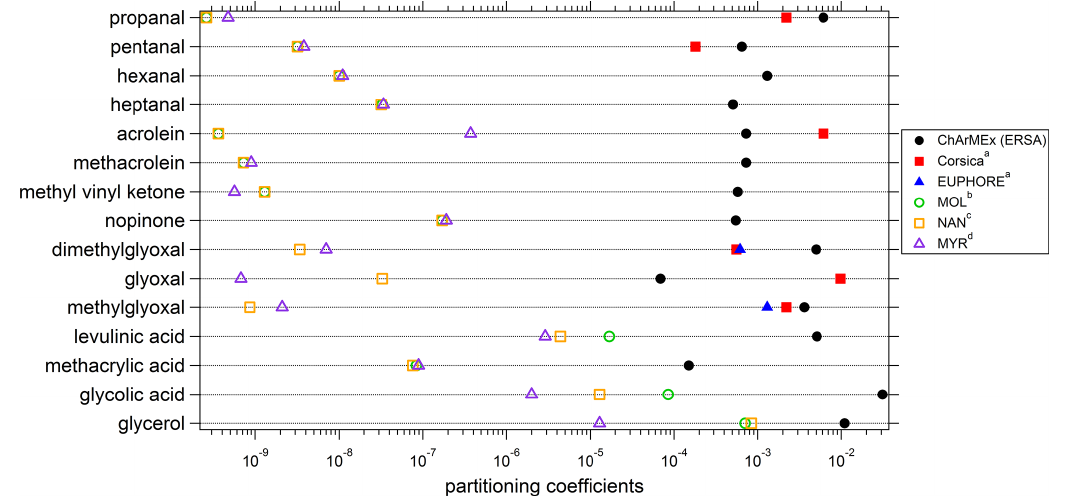
Figure 13. Experimental and theoretical partitioning coefficients determined for this study and compared to previous field and chamber campaigns. a Rossignol et al. (2016), b Moller et al. (2008) (coupled with the Nannoolal et al., 2004, method for boiling point determination), c Nannoolal et al. (2008) (coupled with the Nannoolal et al., 2004, method for boiling point determination), d Myrdal and Yalkowsky (1997) (coupled with the Nannoolal et al., 2004, method for boiling point